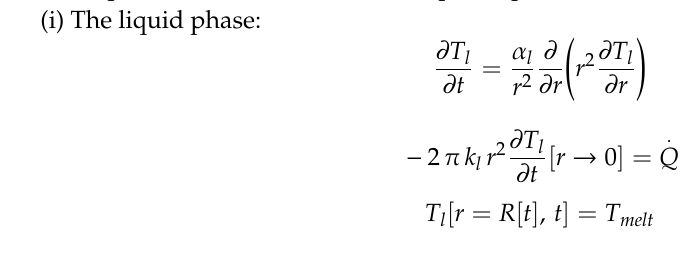
Figure 1. Schematic representation of a cross section of the physical problem, which is spherically symmetric. The molten material has the shape of a hemisphere with radius R [ t ] that denotes the location of the interface. The melting is due to a laser delivering a power Q at the point 0 of the semi-infinite solid material (powder).